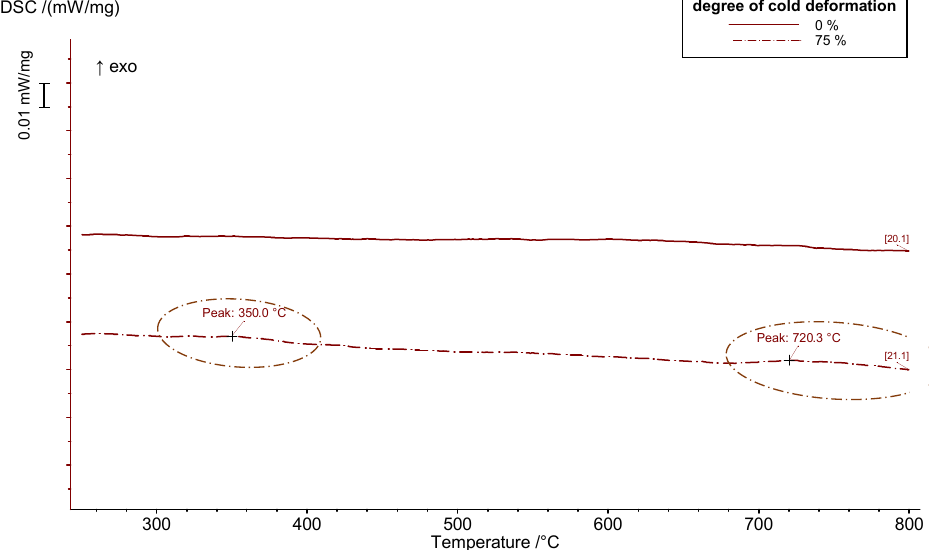
Figure A12. DSC measurement for Cu-OFE with peak temperatures and areas of primary and secondary recrystallization.